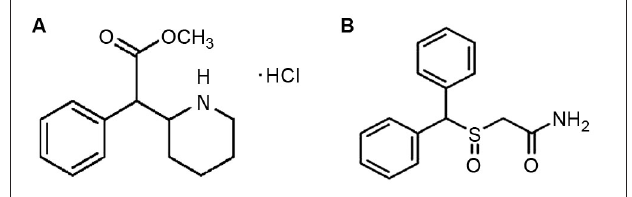
FIGURE 1 | (A) Chemical structure of methylphenidate (Ritalin©). (B) Chemical structure of modafinil (Provigil©). The drug bears a striking resemblance to methylphenidate and other stimulants.